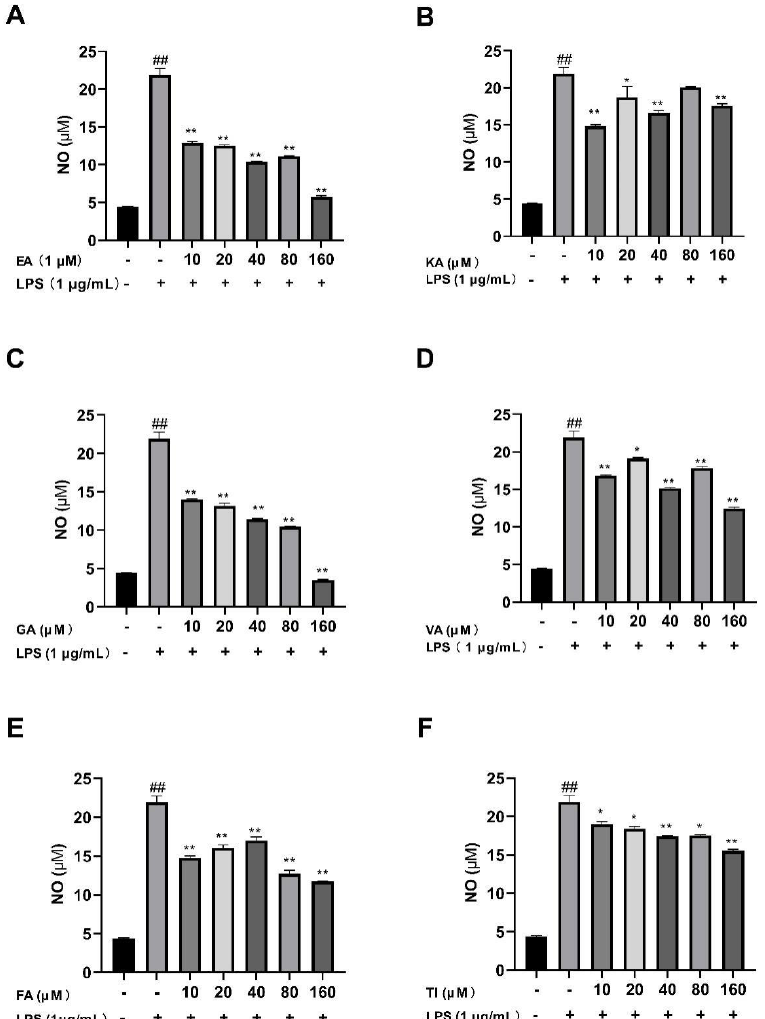
Figure 16. Effects of Ellagic acid ( A : EA), Kaempferol-3-o-rutin glycoside ( B : KA), Gallic acid ( C : GA), Vanillic acid ( D : VA), Ferulic acid ( E : FA), and Tiliroside ( F : TI) on LPS-induced NO release in BV2 cells at 10–160 µ M. − indicates that contain, + indicates does not contain. ## represent significant difference between the representative model group and the control group. * represents significant difference compared with model group (P < 0.05); and ** represents extremely significant difference compared with model group (P < 0.01).